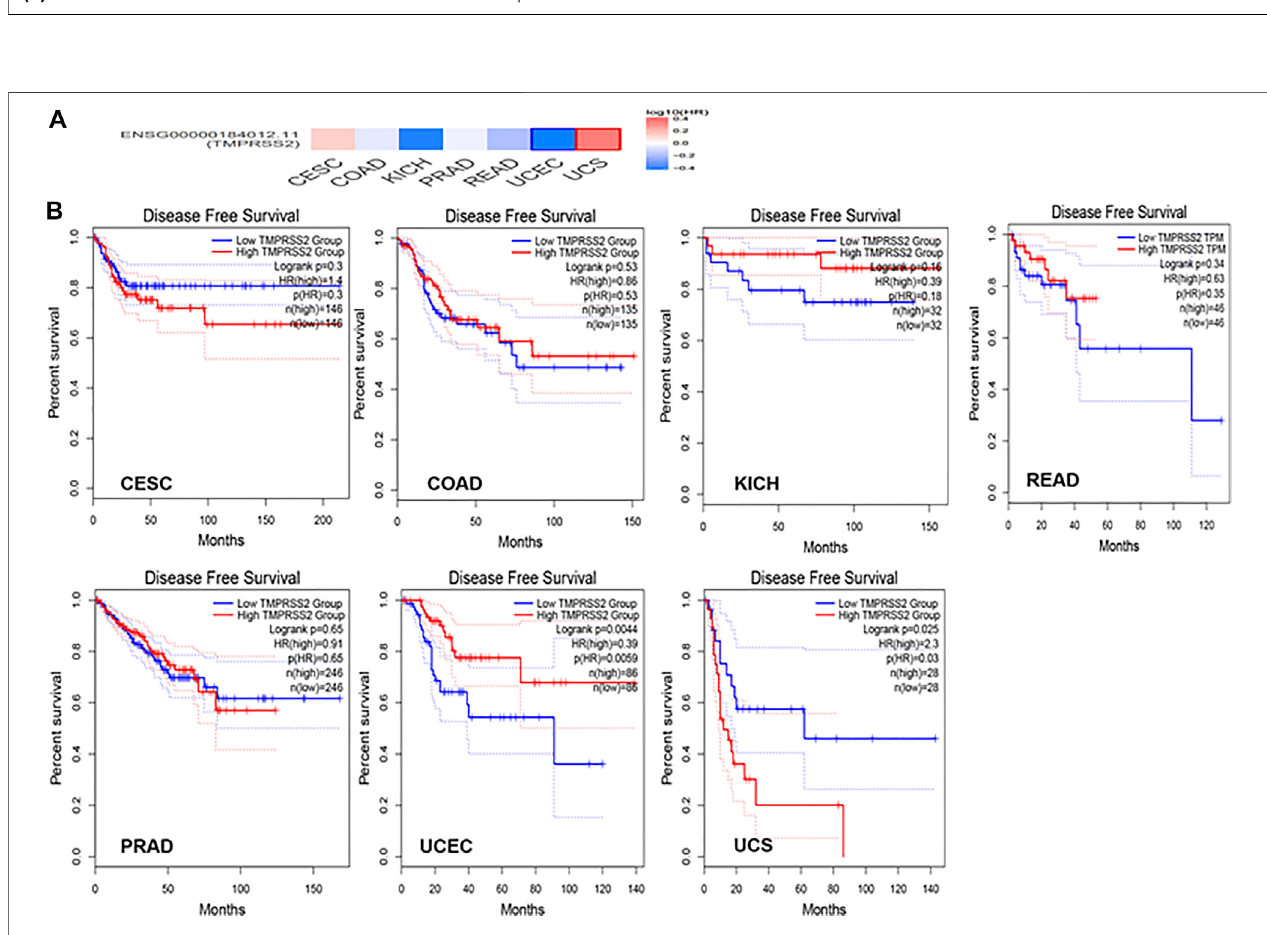
FIGURE6| OSdataofmalignanttumors withlowexpression ofTMPRSS2. (A) Survivalpicture oftumorswith lowexpression ofTMPRSS2; (B) OS intumors with low expression of TMPRSS2.